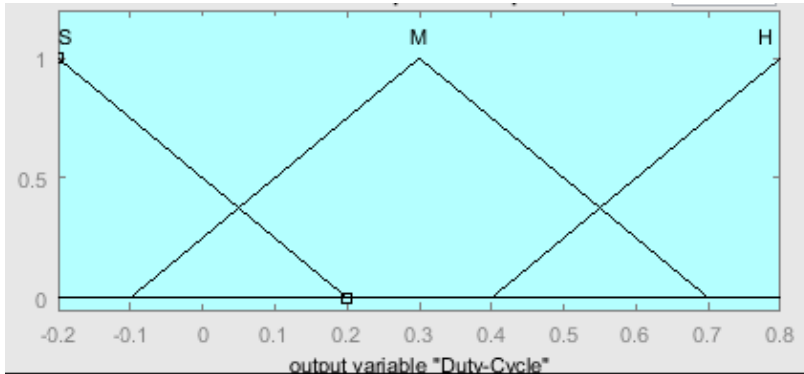
Figure 11. Membership function of output variable in terms in duty cycle.